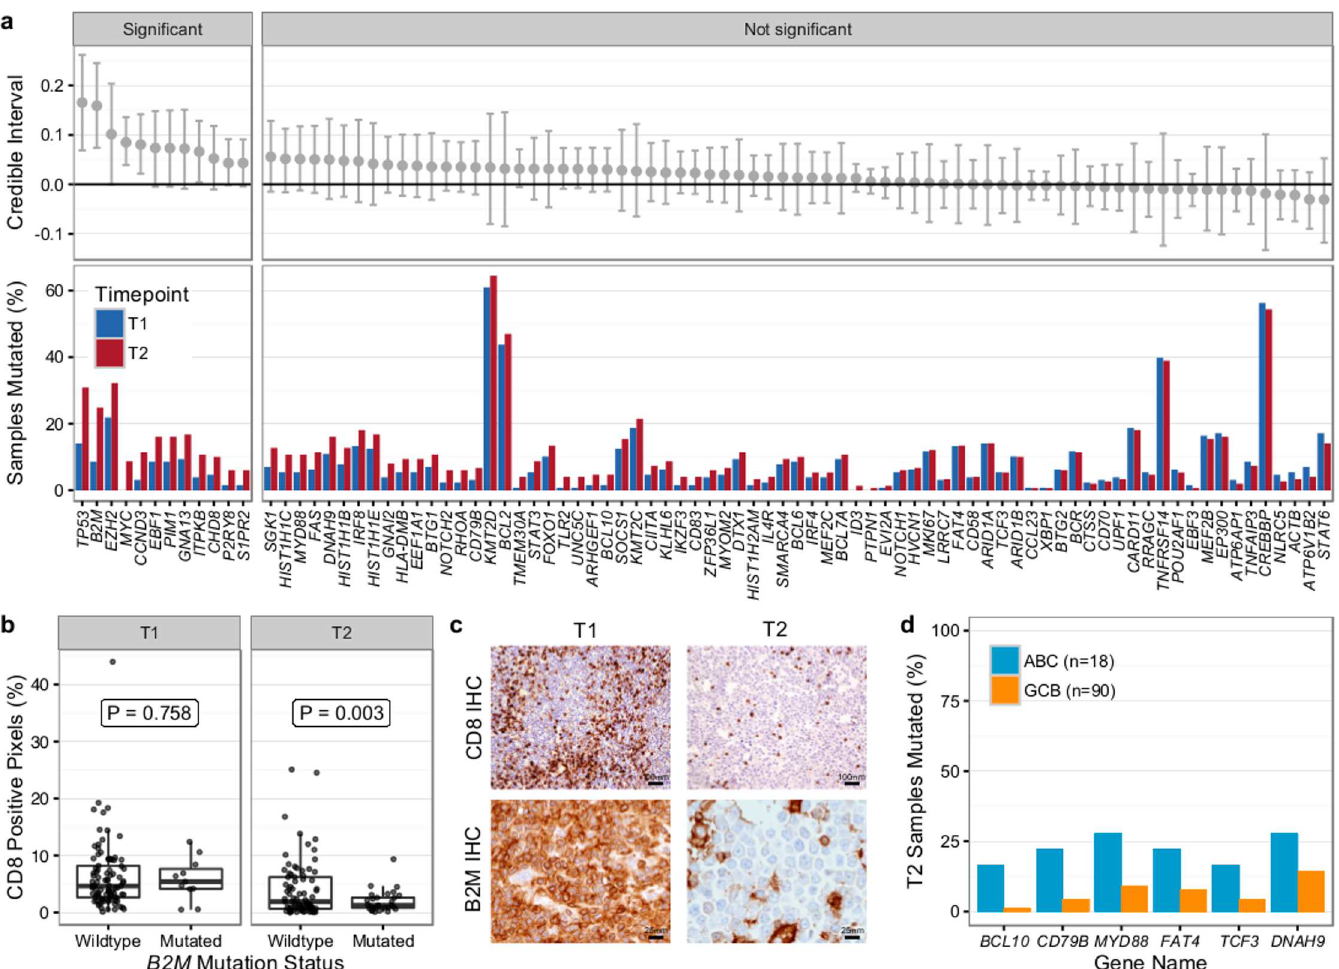
Fig 8. Results from targeted sequencing of 86 genes in samples from 159 transformed follicular lymphoma patients (128 T1 and 149 T2 samples). (A) Credibleintervals from Bayesianproportiontest (top). Genes are ranked by group difference and separated based on whetherthe probabilityof a given geneto be more commonly mutated in T2 is > 0.95 or not. The percentageof samplesharboringmutationsin given genes is given at the bottom. (B) CD8-positive pixel count by Aperio automatedimagingof immunohistochemicallystainedtissue cores, by time point and B2M mutation status. Only cases with pairedinformation on CD8+ T cell scoringand mutation status are shown. (C) Representative microscopy images taken at 200 × or 800 × magnification (CD8 and B2M, respectively). (D) Proportionof mutated samples by cell of origin (activated B-cell-like[ABC] or germinalcenter B-cell-like[GCB]); shown are only genes that are significantly associatedwith either subtype (Fisher p < 0.05). IHC,